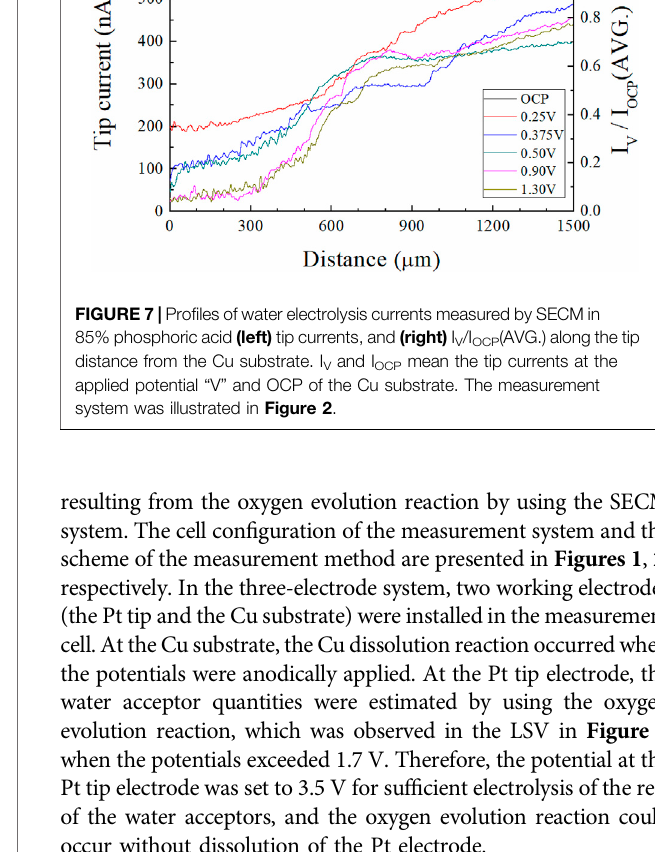
FIGURE 6 | Nyquist plots of the Cu substrates at various polishing potentials in 85% phosphoric acid measured according to preconditioning time (A) 0 s and (B) 60 s. Frequencies were set on between 50 kHz and 10 Hz.